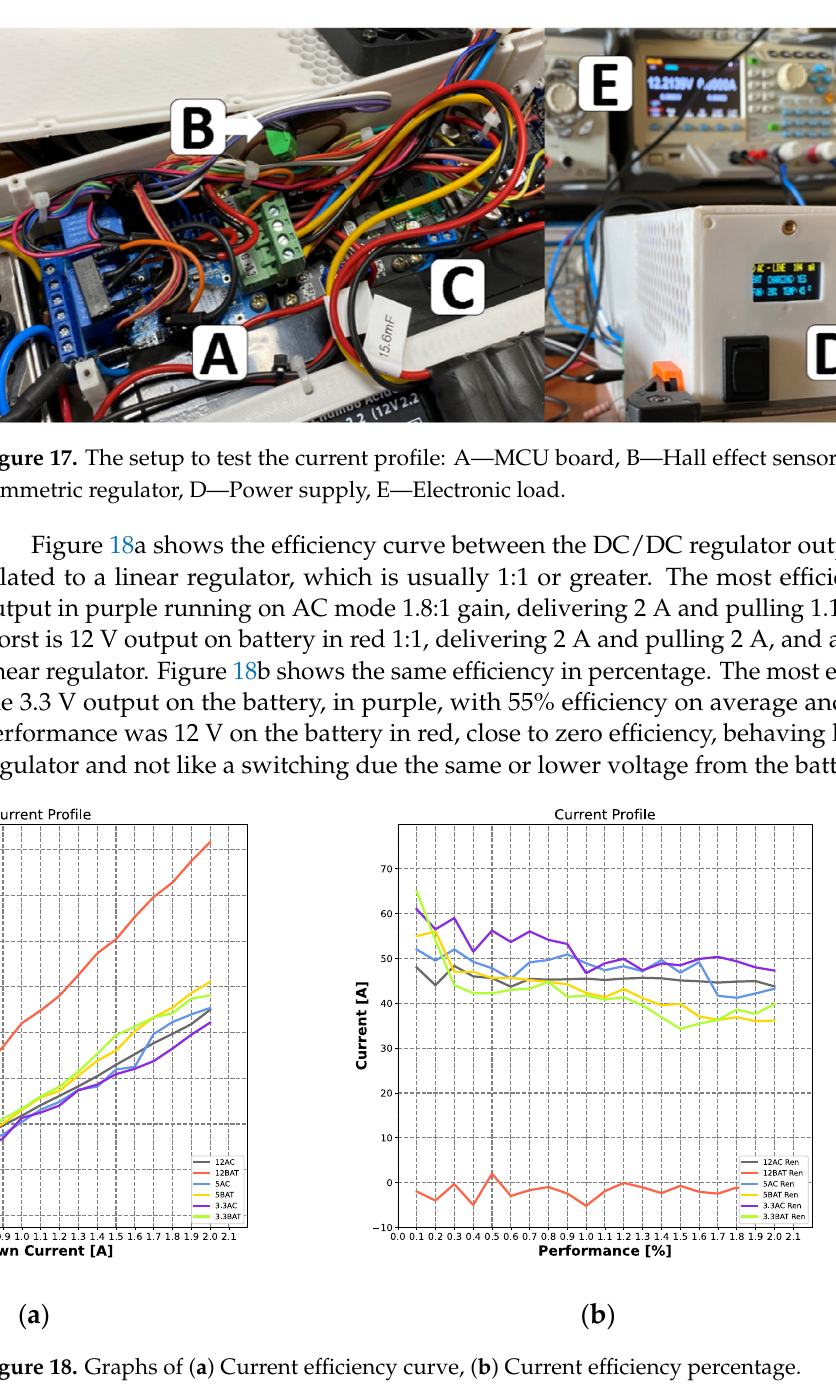
Figure 17. The setup to test the current profile: A—MCU board, B—Hall effect sensor, C—Bipolar symmetric regulator, D—Power supply, E—Electronic load.